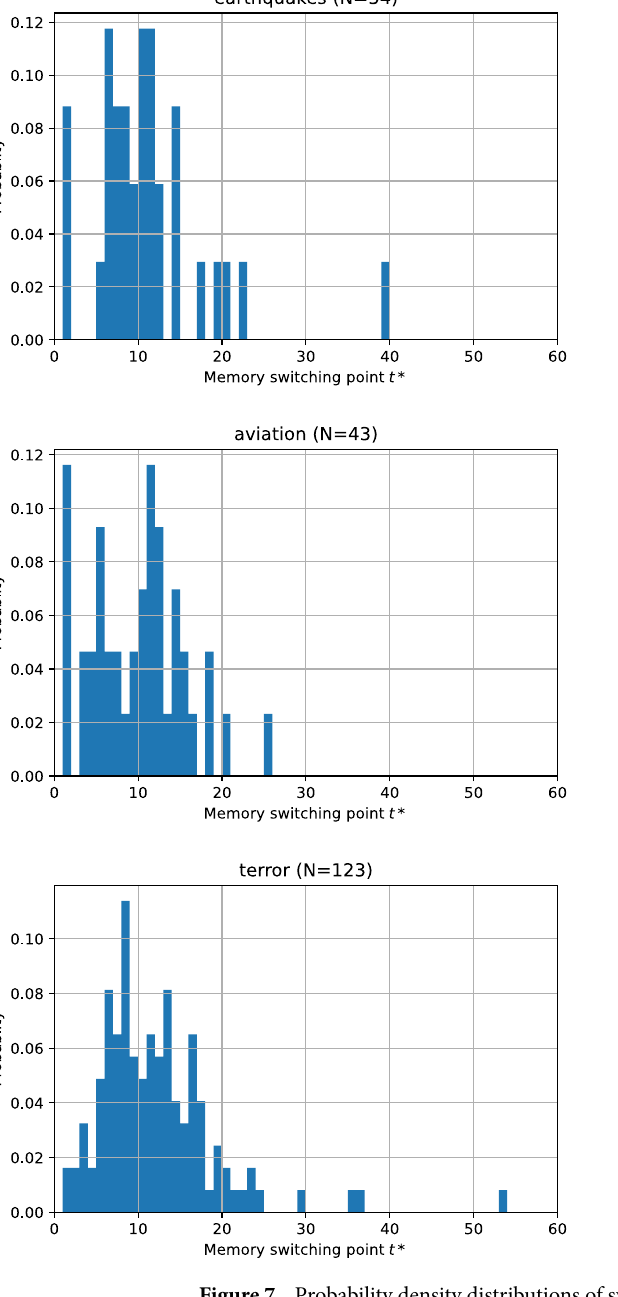
Figure 7. Probability density distributions of switching point t ∗ detected for five categories. Most of the samples fall within 0 < t ∗ < 40 days, which is relatively short compared to the maximum length of the time series (300 days). The median values of t ∗ are 10 to 11 days for all